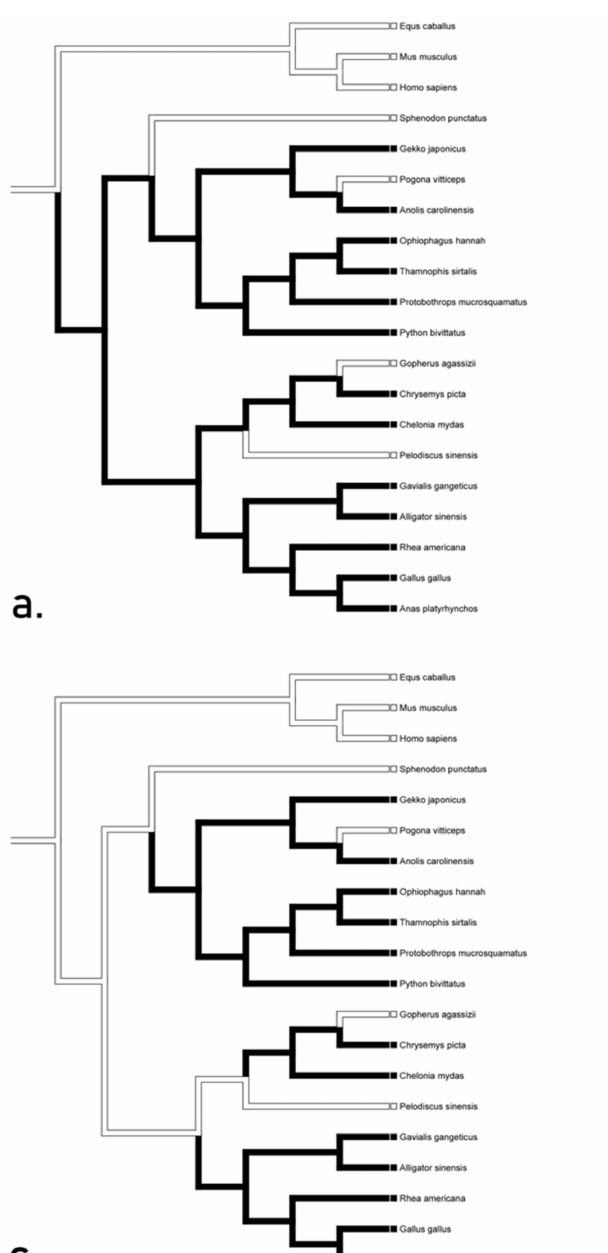
Figure 5. Character optimization of TLR 15 using accelerated ( a ) delayed ( b ), and mixed ( c ) transfor- mations showing its unique evolution in reptilian and avian lineages. Accelerated transformations hypothesize conservation throughout Reptilia with losses in P. viticeps, G. agassizii, and P. sinesis , while delayed and mixed inferences suggest convergence between squamates and members of Archosauramorpha as well as a loss in the aforementioned